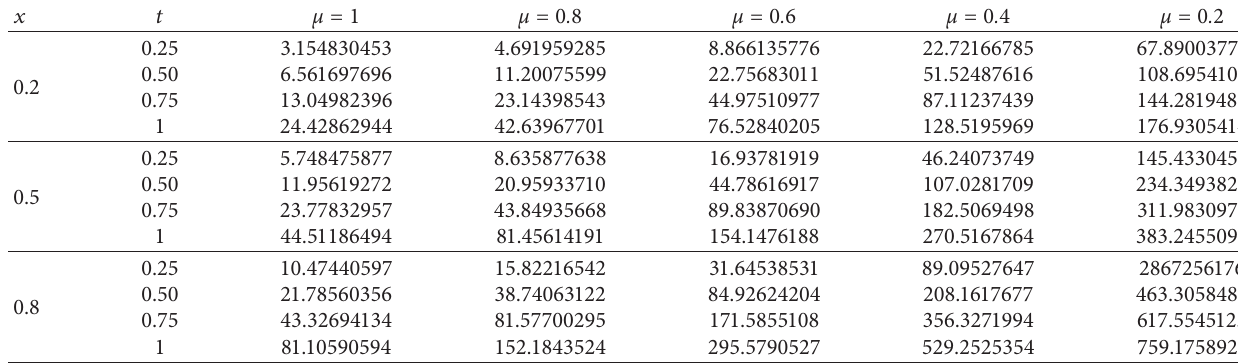
Table 5: Numerical values for u (x, t) of equation (61) for different values of x and t .